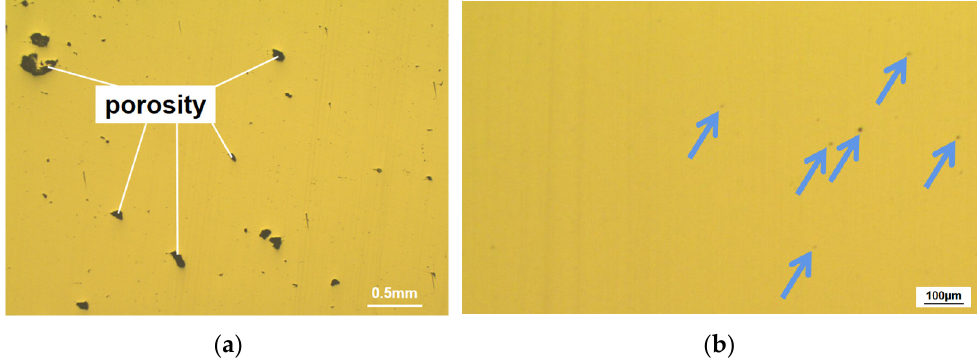
Figure 6. Cross-section of SLMed HEA sample with obvious ( a ) and permissible defects ( b ).